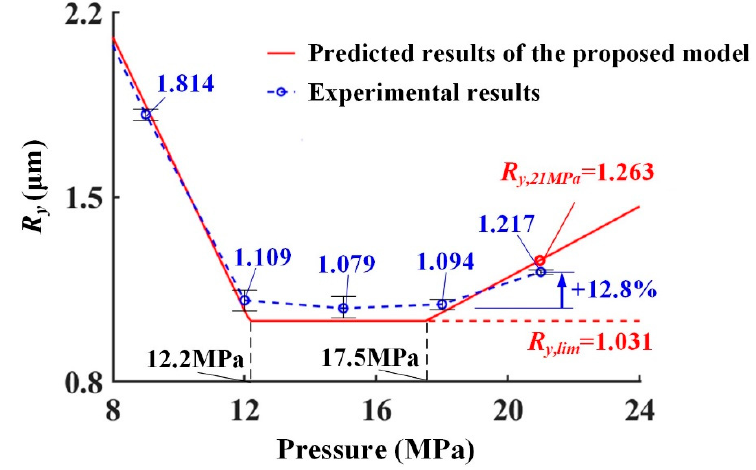
Figure 12. Experimental results and predicted results for LPBed Inconel 718.